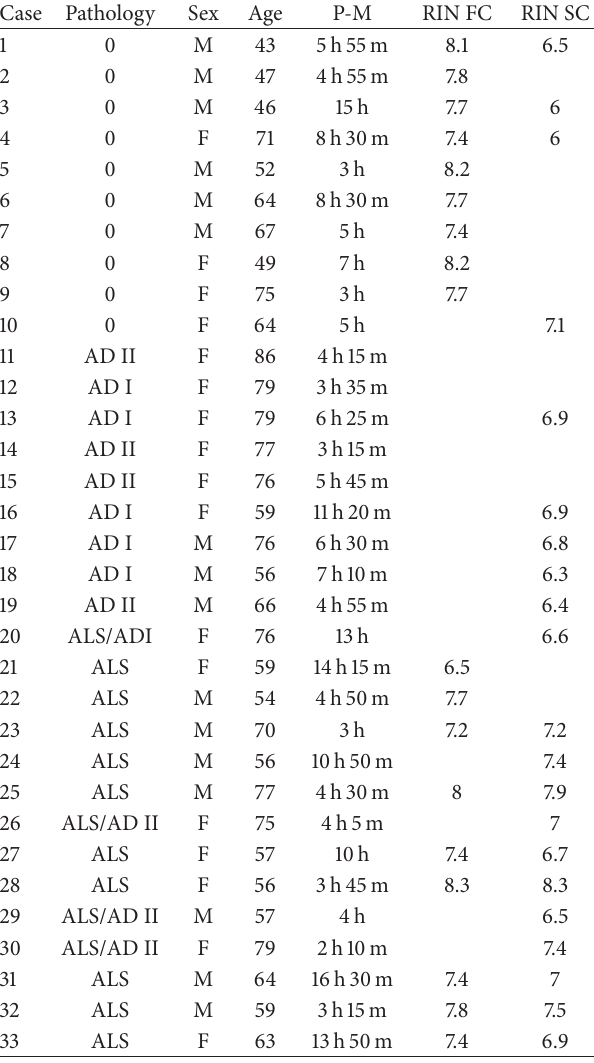
Table 1: Summary of clinical and pathological data in the present